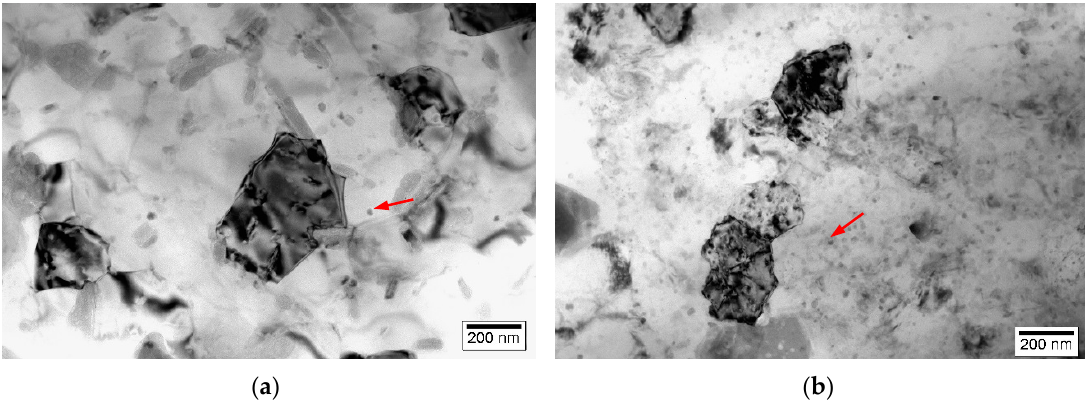
Figure 5. TEM micrograph showing aluminium grains and nanosized dispersoids (arrows) in ( a ) V and ( b ) AF ‐ 5 sintered compacts.